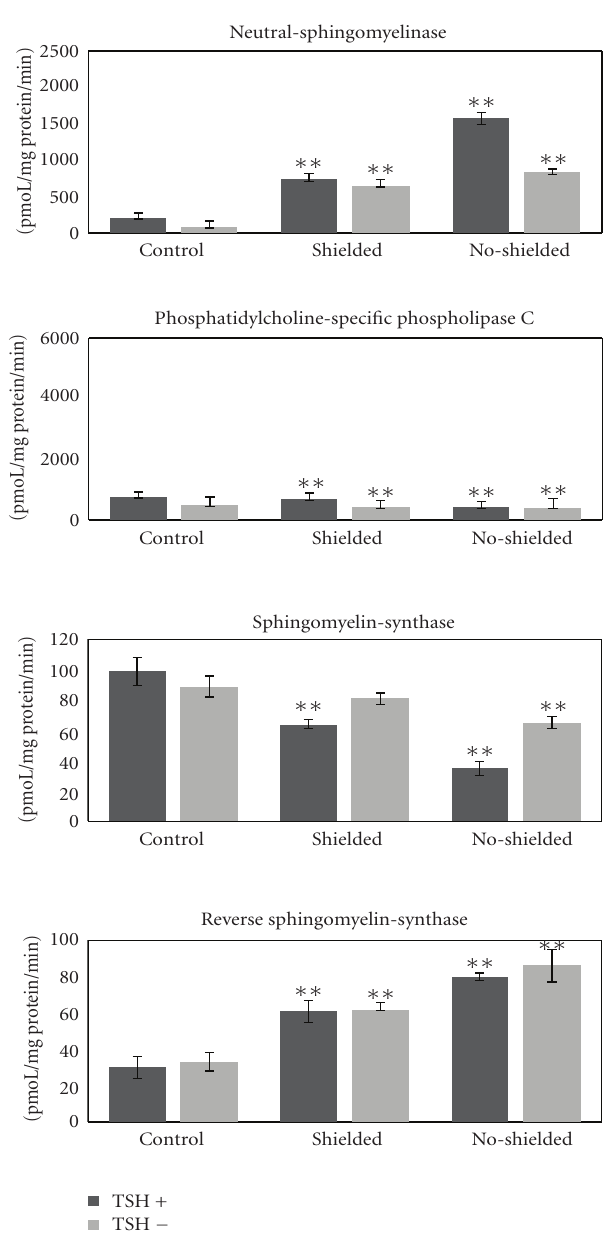
3: Neutral-sphingomyelinase, phosphatidylcholine- specific phospholipase C, sphingomyelin-synthase, and reverse sphingomyelin-synthase activities in purified nuclei of FRTL-5 cell cultured in the presence of TSH (TSH+). Data are expressed as pmol/mg protein/min and are the mean ± S.D. of three samples performed in duplicate. ∗∗ P < . 001 versus control